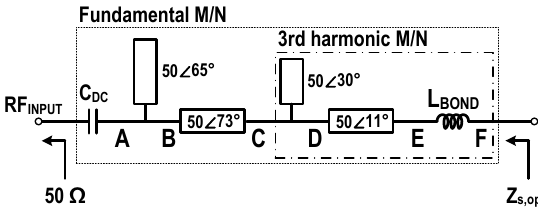
Figure 6. Schematic of the input matching network.